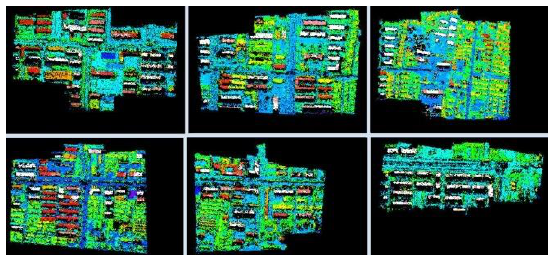
Figure 8. The image matching 3D points of control images